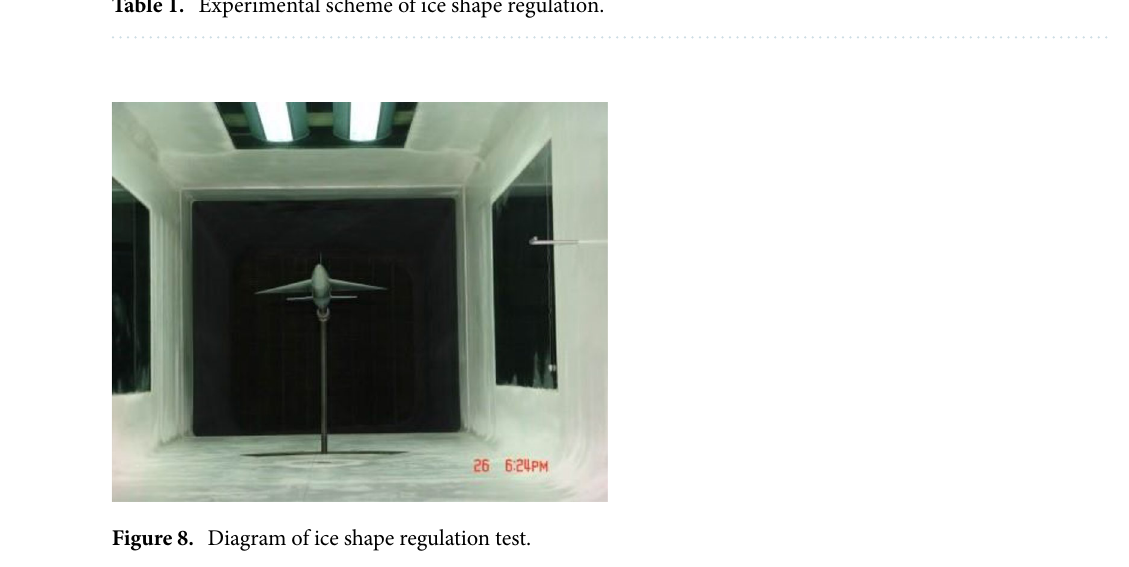
Table 1. Experimental scheme of ice shape regulation.